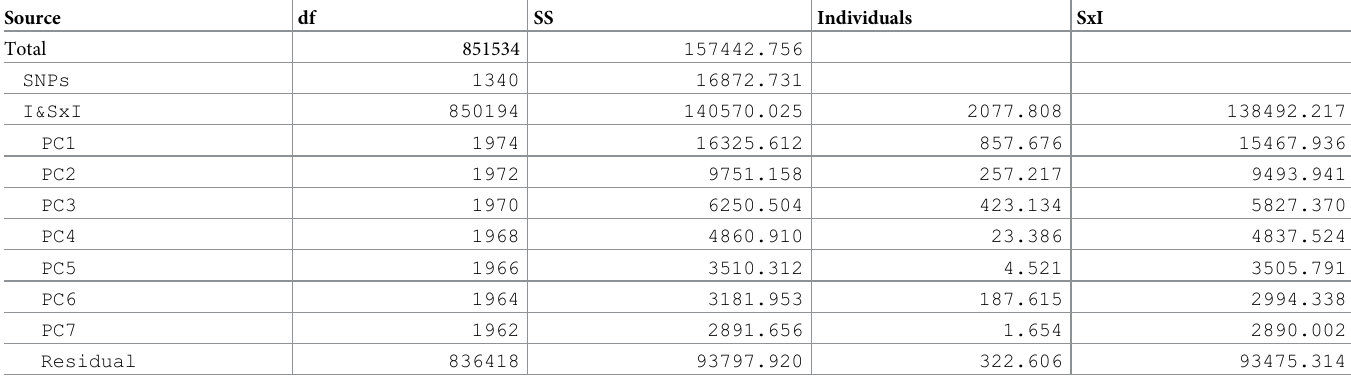
Table 2. Augmented ANOVA table for SNP-Centered PCA of SNP data on oats, using SNP coding rare = 1. PCA is applied to Individual main effects and S × I interac- tion effects combined (I&S × I), and the portion of each is shown in the last two columns.